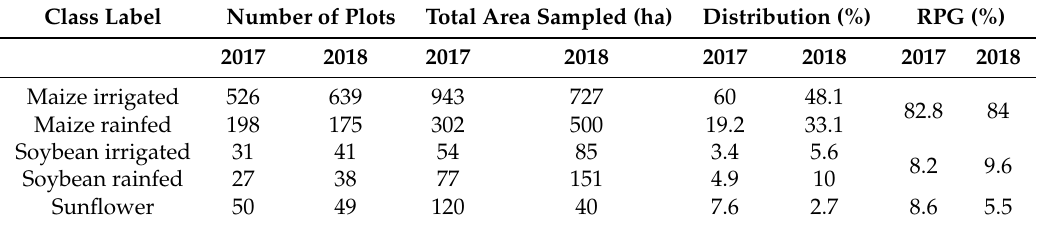
Table 2. Distribution of reference dataset by class for 2017 and